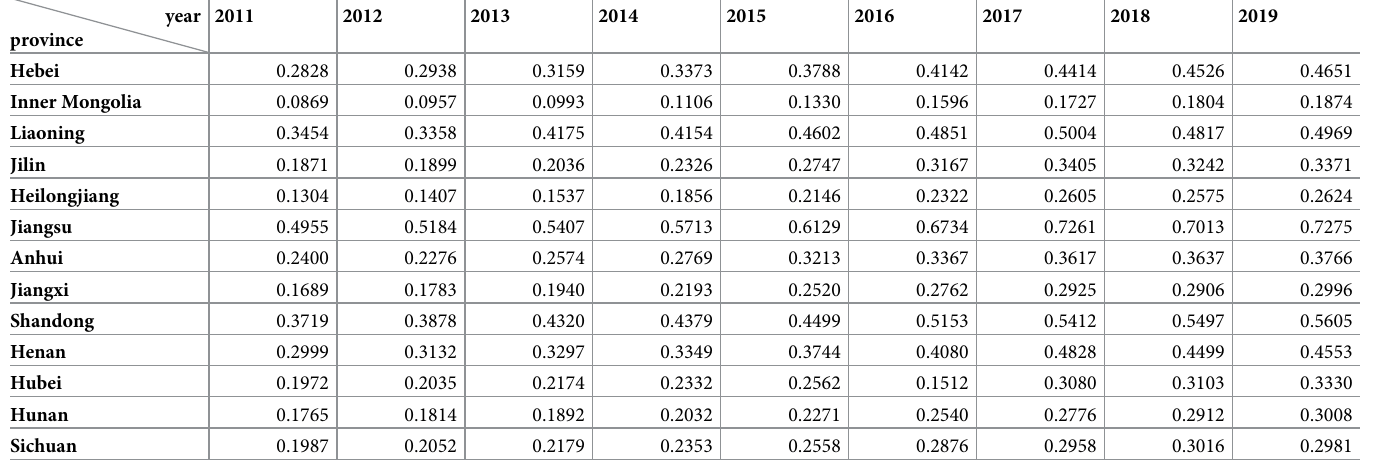
Table 2. Index of Financial Inclusion of 13 provinces in China’s major grain producing areas from 2011 to 2019.